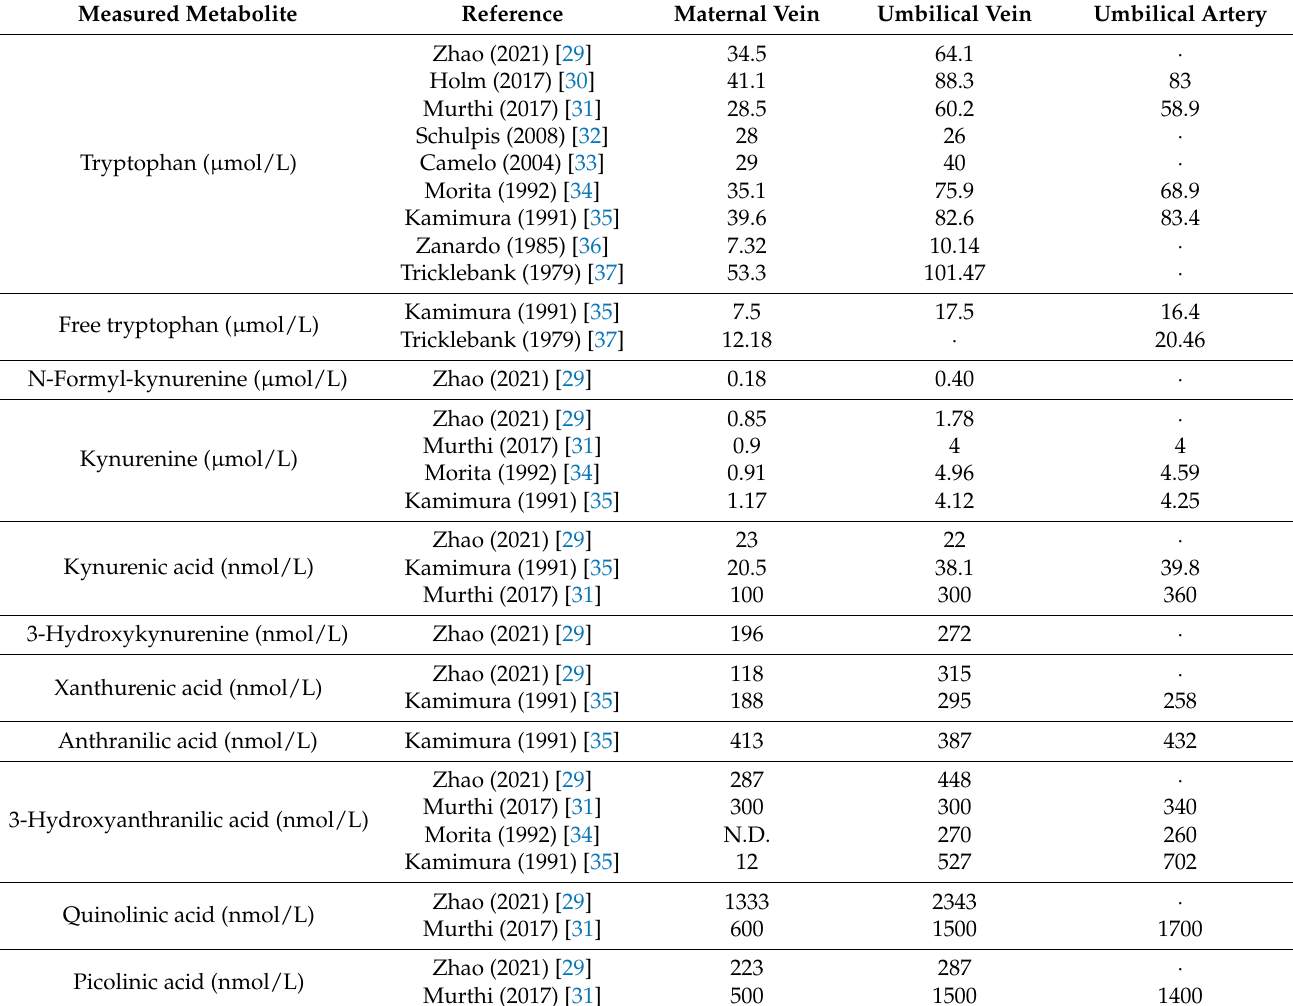
Table 1. Tryptophan and kynurenine pathway metabolites concentrations in the maternal and fetal circulation at the end of